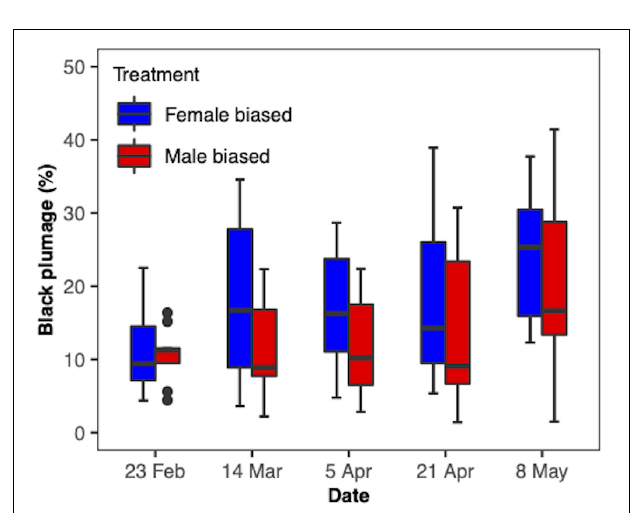
FIGURE 5 | Mean body mass ± SE (g) of male yellow-rumped warblers ( Setophaga coronata coronta ). The birds were photostimulated to enter a migratory state on 21 April and released back to the wild on 8 May 2019.